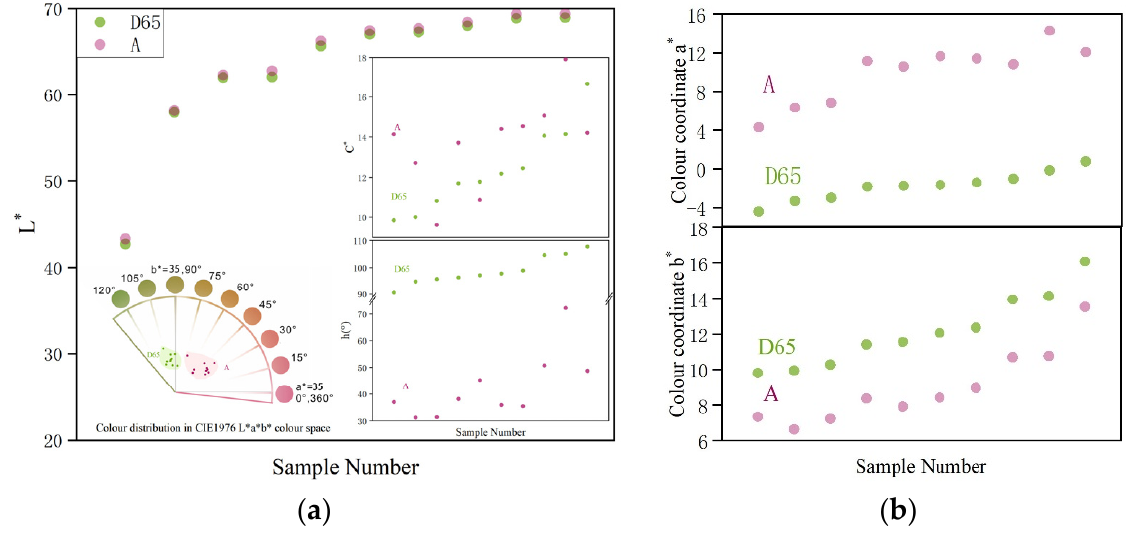
Figure 8. Comparison of colour parameters under two kinds of standard light sources. ( a ) Comparison of lightness L*, chroma C*, and hue angle h(°); ( b ) Comparison of colorimetric coordinates a* and b*.